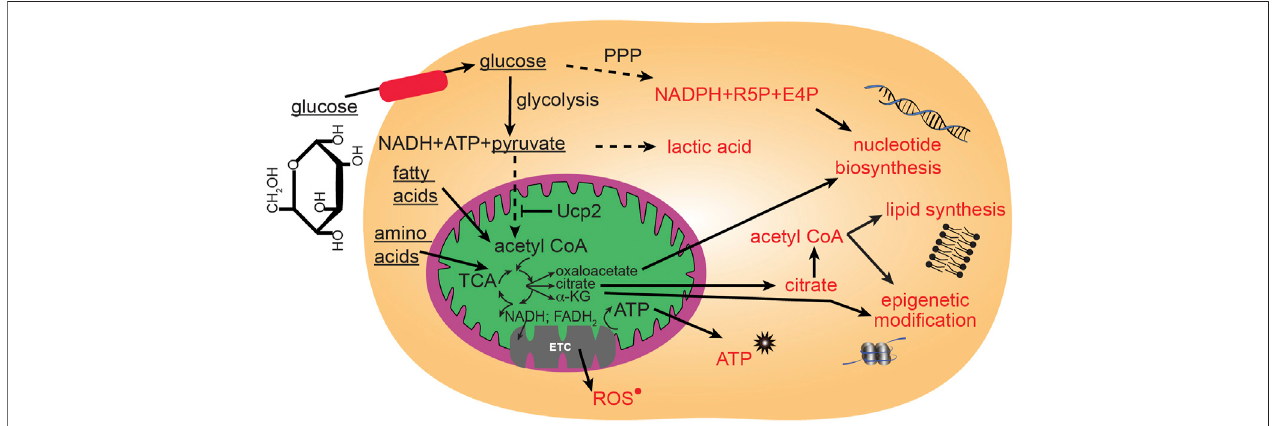
FIGURE 2 | Major glucose metabolic pathways. Mitochondria participate in utilization of glucose through the citric acid (TCA) cycle that can then proceed to anabolicpathwaysusingTCA intermediates,orproceed tooxidative phosphorylationthroughtheelectron transport chain(ETC)togeneratelarge quantitiesofenergy in the form of ATP. Glucose can be metabolized outside of mitochondria to contribute to glycolysis and the pentose phosphate pathway (PPP).